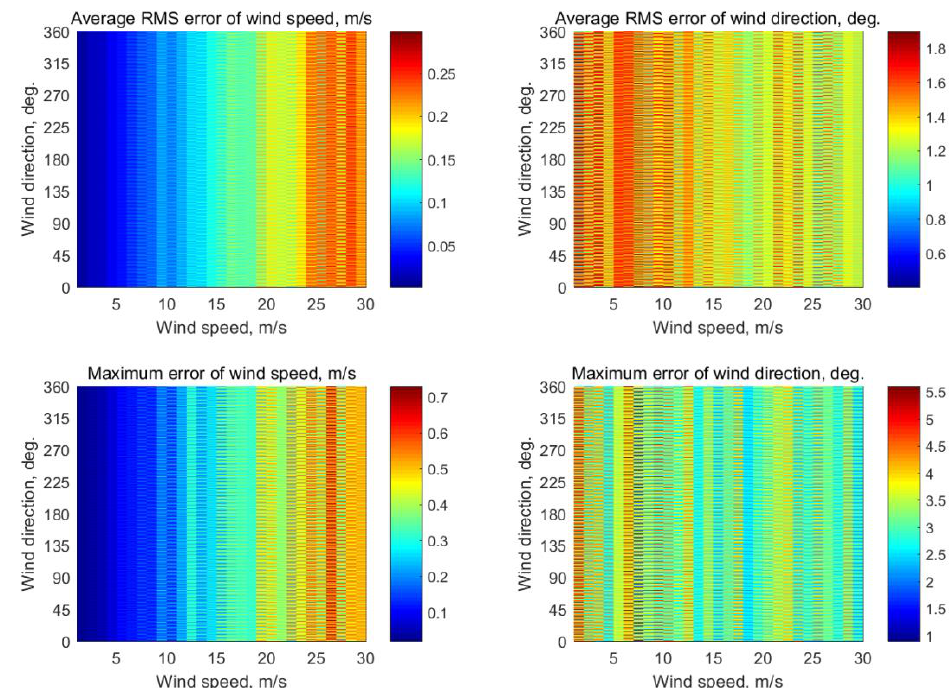
Figure A1. Simulation results of the use of only one incidence angle of 30° for wind retrieval.